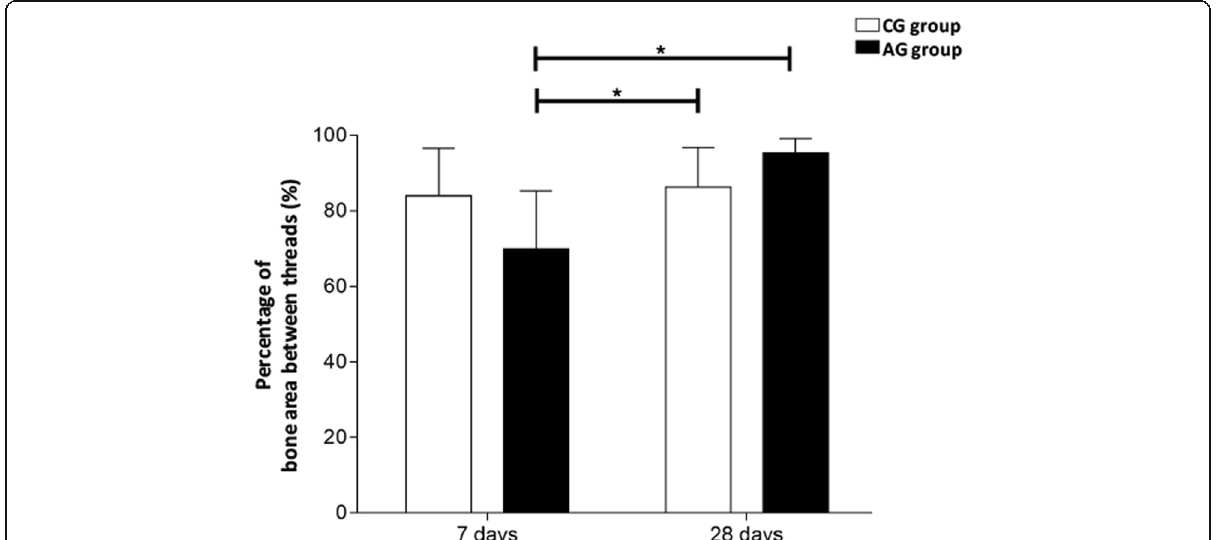
Fig. 2 Effect of low-dose aspirin regarding bone area between threads (BABT). The data represent mean ± SE ( n = 8 animals/group). Asterisk indicates significant difference between the groups (* p < 0.01, ANOVA and post hoc Tukey)